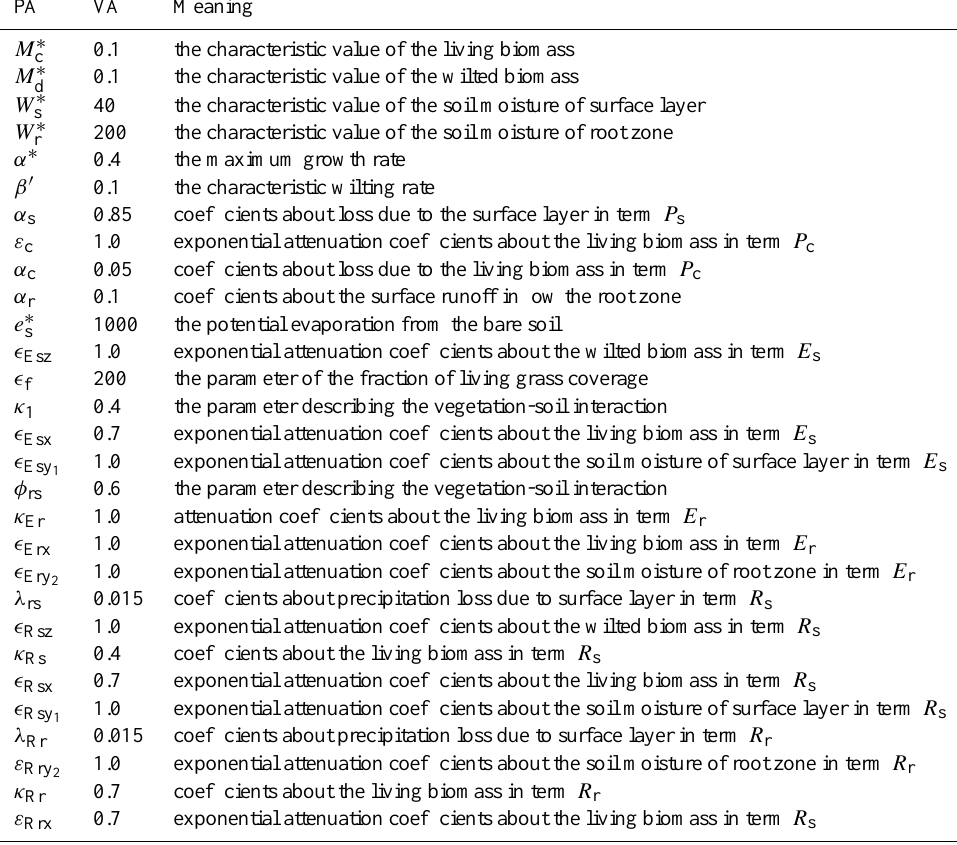
Table A2. The key parameter values in the five-variable ecosystem